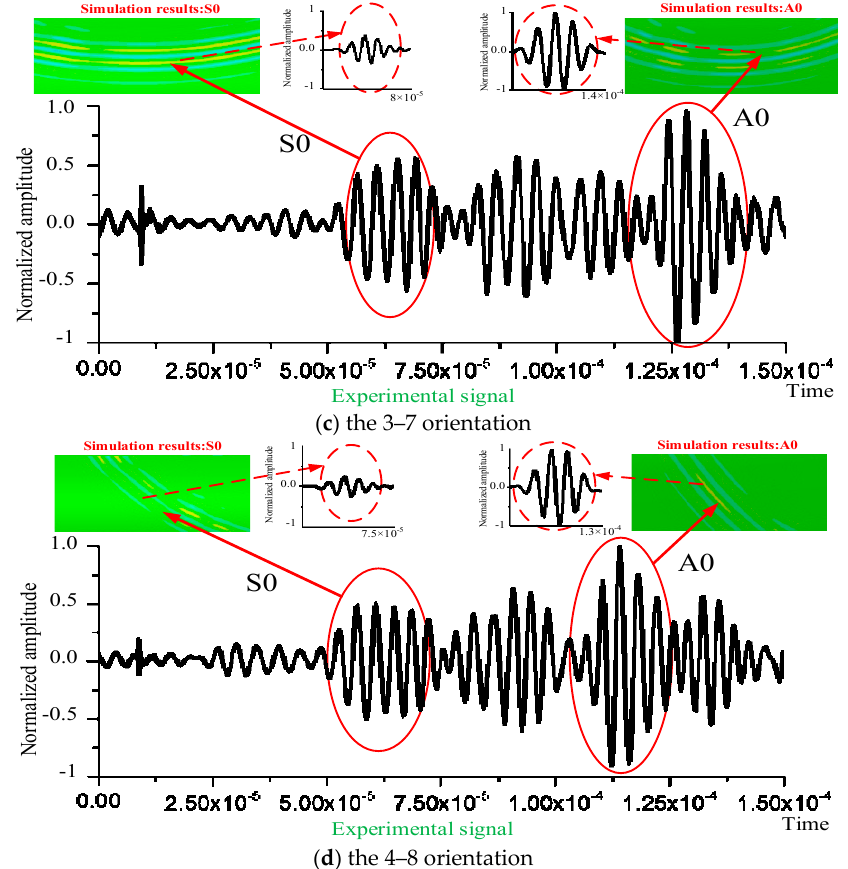
Figure 8. Comparisons between the simulation and the experimental results.